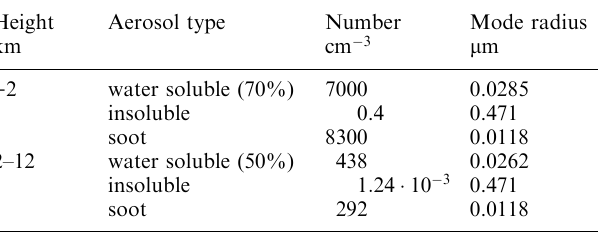
Table 11. Aerosol conditions used for calculations Height Aerosol type